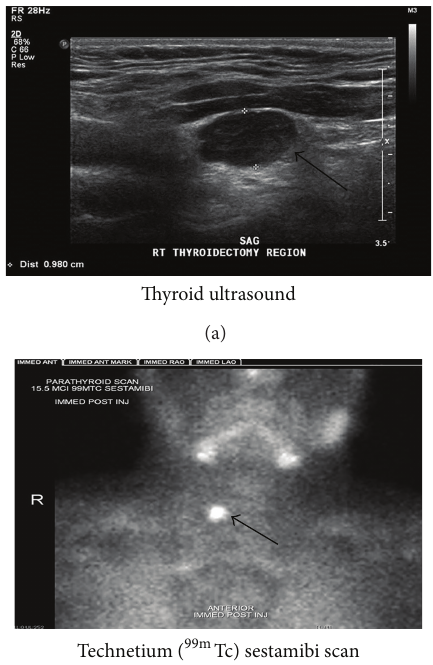
Figure 1: Ultrasound (a) and technetium ( 99 m Tc) sestamibi scan (b) of nonpalpable 1cm nodule in right neck prior to removal of parathyroid